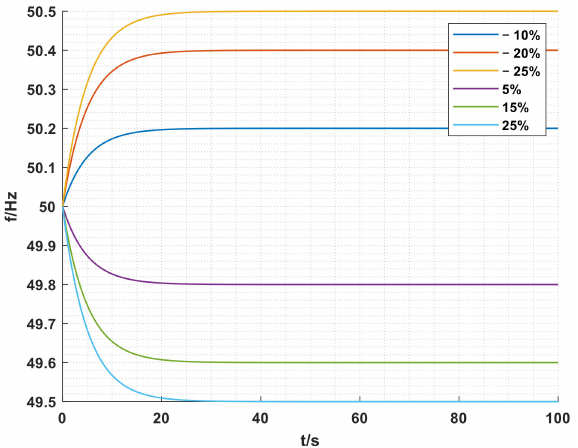
Figure 8. Frequency Change amplitude Calculation—Simulation Results.